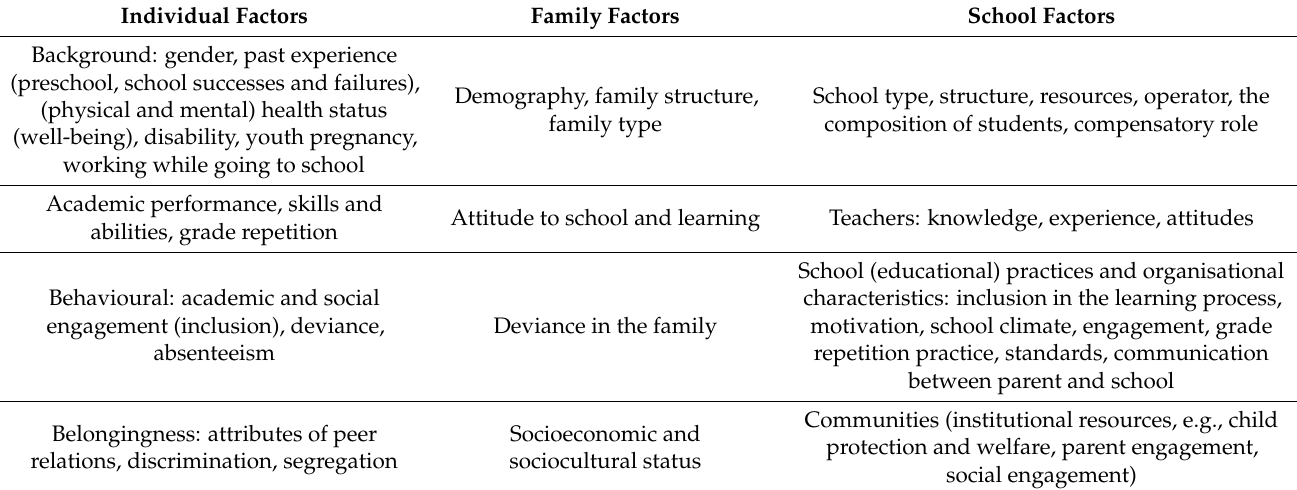
Table 1. Individual, family and school factors of